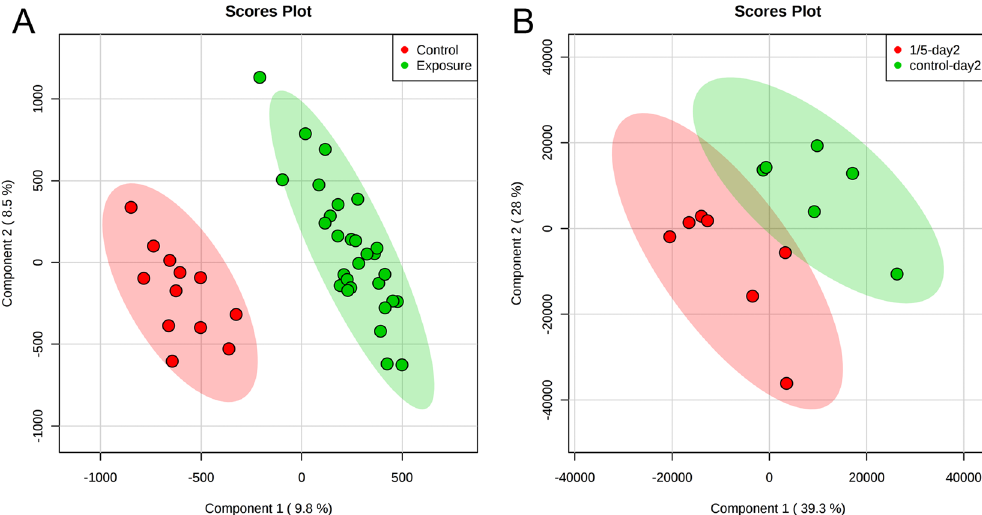
Figure 3. Score plot of partial least squares discriminant analysis using features from ( A ) LC-QTOF spectra (Control versus Exposure) and ( B ) GC-MS spectra (control-day 2 versus 1/5 LC 50 -day2) after acute exposure.